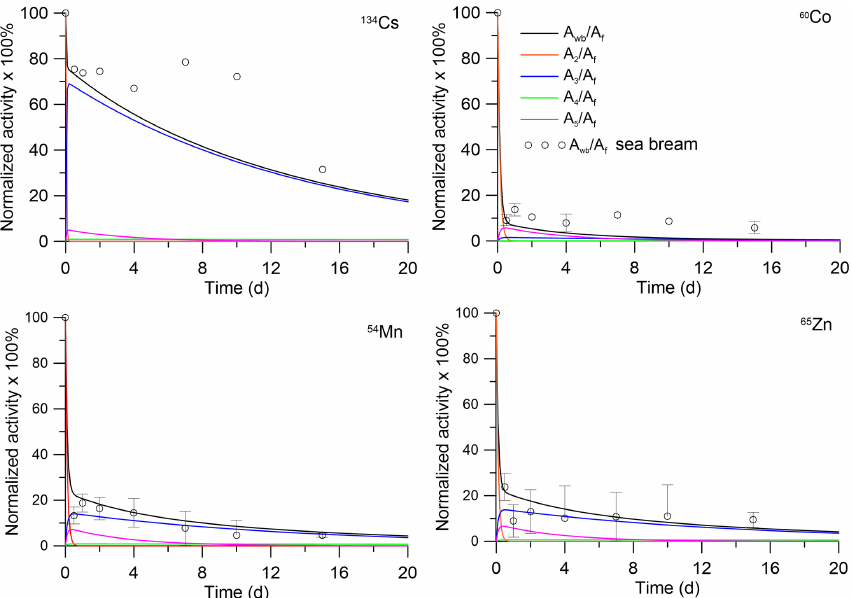
Figure 3. Retention of radionuclides in whole body and tissues of juvenile sea bream ( Sparus auratus ). The simulations are compared with whole-body measurements by Mathews and Fisher (2008).